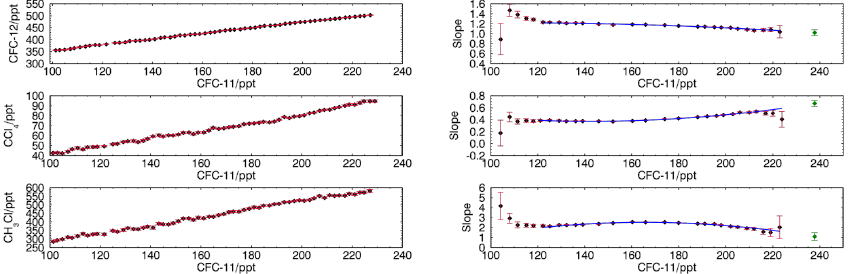
Figure B3 Correlations between the volume mixing ratios of CFC-12, CCl 4 , and CH 3 Cl and CFC-11 for the data from the northern hemisphere during the stratospheric summer of 2008. Left panels: The mean correlation profile. Each point represents the mean of the VMR in a window of 2 ppt of CFC-11. The error on these points is the standard deviation of the data within each 2 ppt window. Right panels: The local slope of data in an 80 ppt of CFC-11 window. The error on the points is the fitting error of this fit. The blue line is a second degree polynomial fit to the local slopes. The green point is the extrapolated slope at the tropopause.